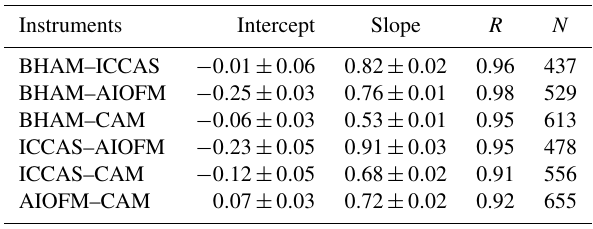
Table 4. RMA regression analysis (with 95% confidence intervals) for times when the abundance of HONO was less than 2ppb as mea- sured by CAM during the formal winter intercomparison period. Variability shown is the 95% confidence interval of the slope and